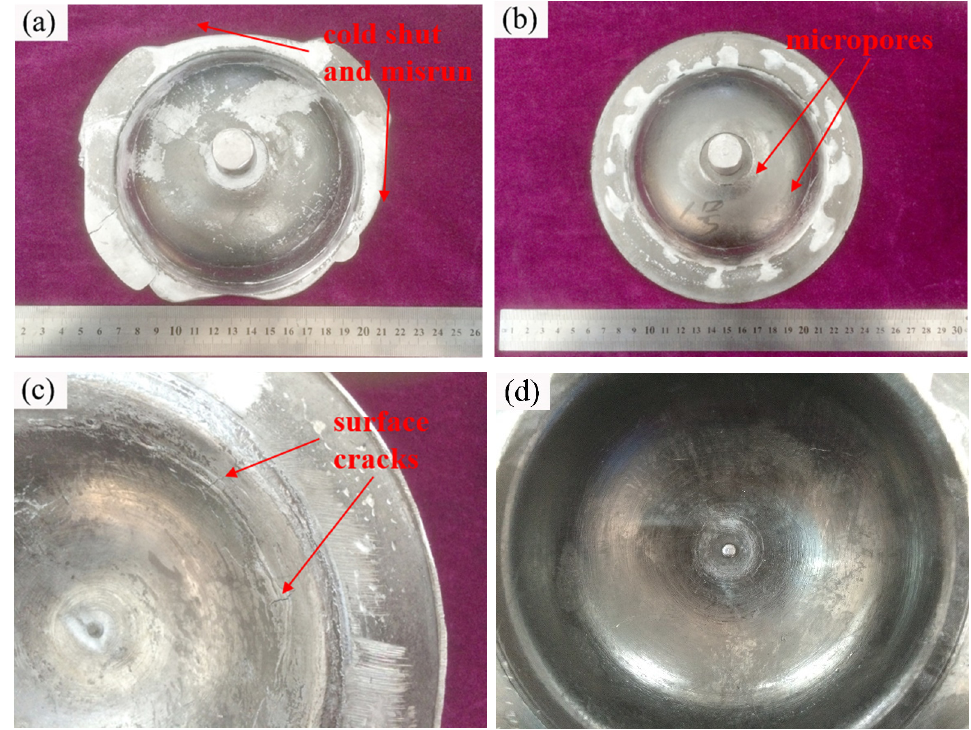
Figure 6. Macroscopic morphology of formed parts: ( a ) cold shut and misrun; ( b ) micropores; ( c ) surface cracks; ( d ) surface with no defects.